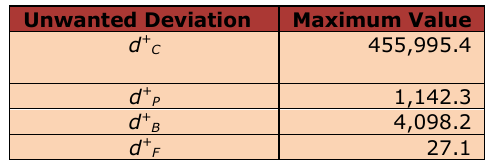
Table 1. the Worst Possible of Deviational